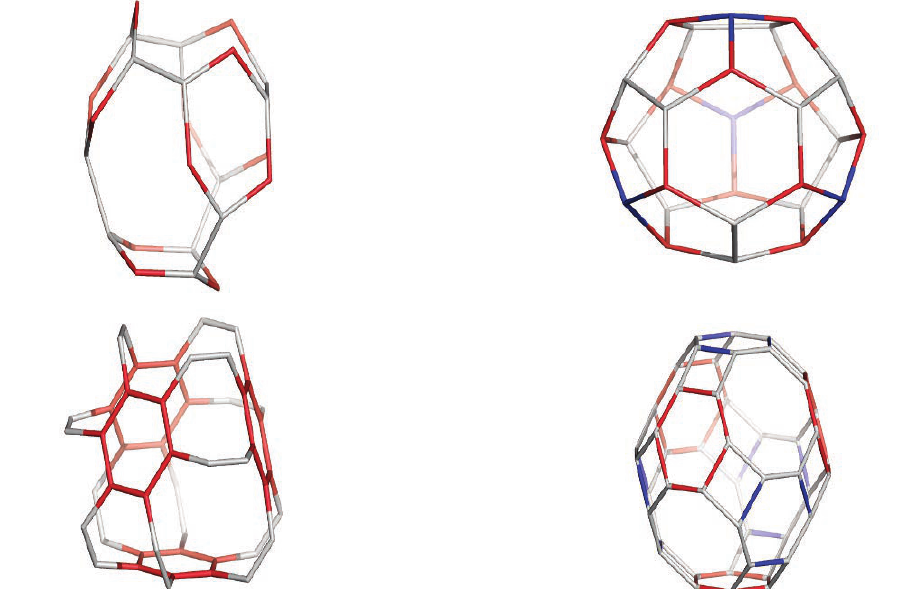
Figure 2. Top row: BTZ_24 designed from S row: BTA_48 formed by spanning the Le(P